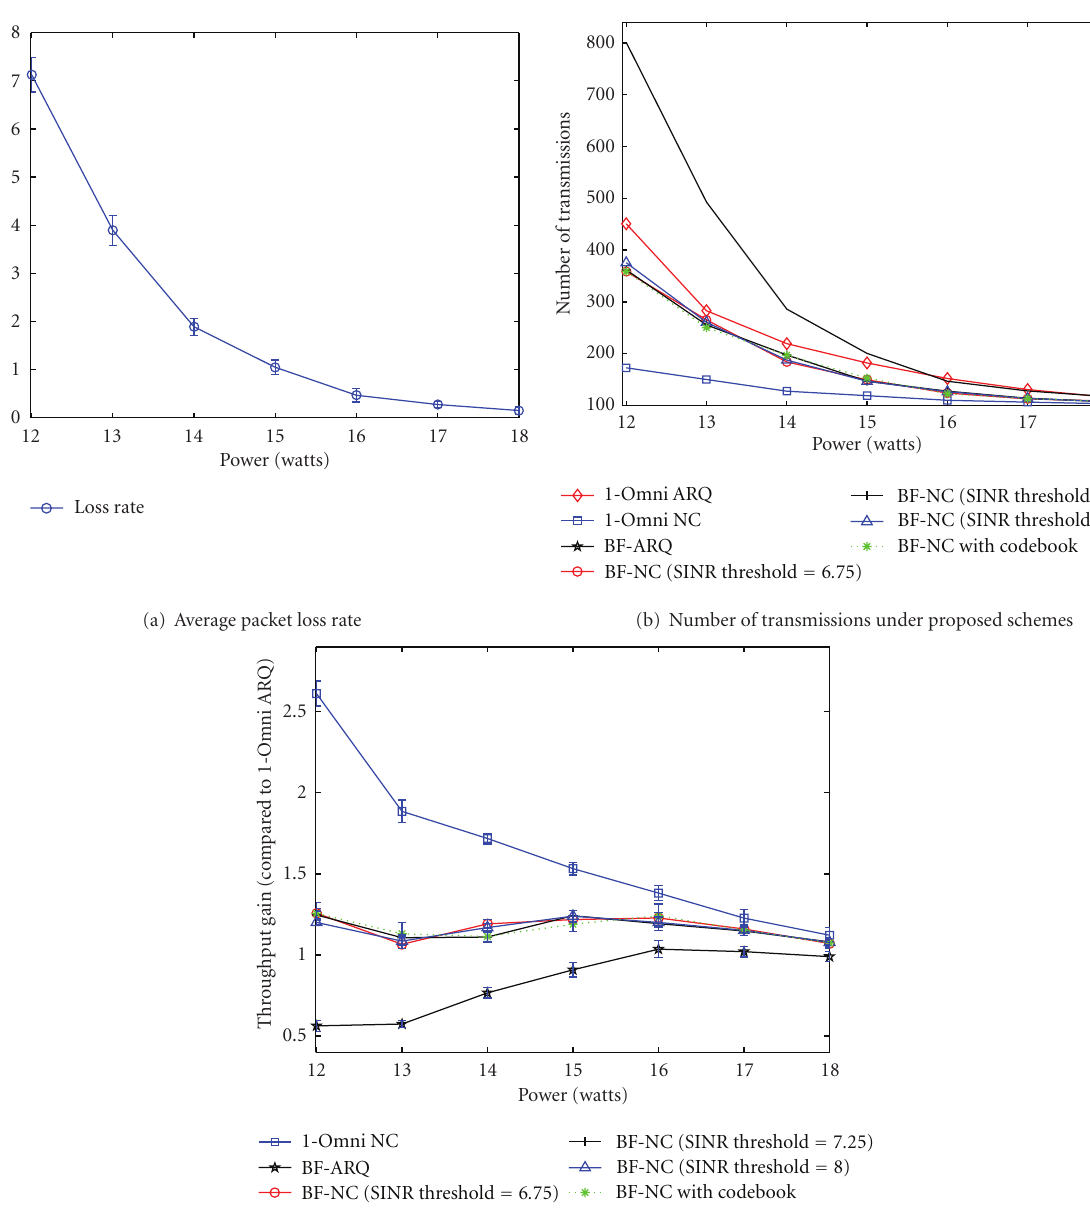
Figure 10: Simulation results for network topology scenario of Figure 7(c) with 120 randomly distributed MSs inside a